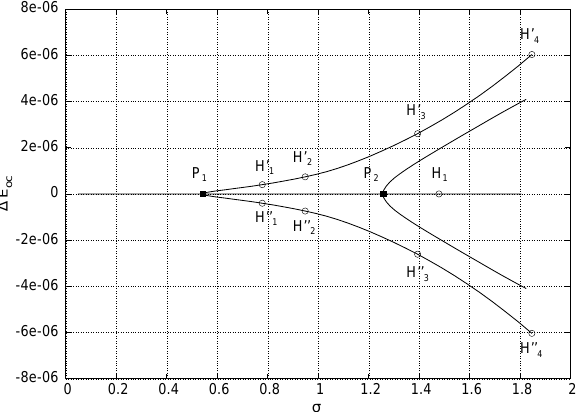
Fig. 2: Bifurcation diagram of the oceanic circulation. The energy difference ∆ E oc between the Fig. 2. Bifurcation diagram of the oceanic circulation. The en- subpolar and the subtropical gyre is plotted as a function of the wind intensity σ in nondimensional ergy difference 1E oc between the subpolar and the subtropical units; all other model parameters equal their values in Table 1. The square P 1 marks a supercritical gyre is plotted as a function of the wind intensity σ in non- pitchfork bifurcation and the square P 2 a subcritical pitchfork bifurcation, the equilibrium branch dimensional units; all other model parameters equal their values in between the two being unstable. Given the large number of unstable branches in the atmospheric Table 1. The square P 1 marks a supercritical pitchfork bifurcation model (see Fig. 5 in section 4 below), we prefer for clarity’s sake not to use the customary dashes and the square P 2 a subcritical pitchfork bifurcation, the equilib- for the unstable branches. The open circles H ′ 1 ,H ′ 2 ,H ′ 3 ,H ′ 4 and H ′′ 1 ,H ′′ 2 ,H ′′ 3 ,H ′′ 4 mark the rium branch between the two being unstable. Given the large num- positionofsuccessivesupercriticalHopfbifurcationpoints,atwhicheitherequilibriumbranchloses ber of unstable branches in the atmospheric model (see Fig. 5 in the stability of yet another complex conjugate eigenvalue; see text for details. Sect. 4 below), we prefer for clarity’s sake not to use the customary respecttotheEast-Westaxisofthebasinisbrokenandthepitchforkbifurcationtakestheperturbed dashes for the unstable branches. The circles H 0 1 ,H 0 2 ,H 0 3 ,H 0 4 form shown by Jiang et al. (1995). Still, for a wide range of σ -values, one finds a nearly antisym- 185 and H 00 1 ,H 00 2 ,H 00 3 ,H 00 4 mark the position of successive super- metric flow pattern. critical Hopf bifurcation points, at which either equilibrium branch For the value of the oceanic Reynolds number R oc =5 × 10 3 in Table 1, there are two successive loses the stability of yet another complex conjugate eigenvalue (see pitchfork bifurcations, which give respectively two branches of asymmetric equilibria, symmetric text for with respect to each other. The bifurcation at P 1 is supercritical, as the antisymmetric branch loses its stability to the two asymmetric ones, while the one at P 2 is subcritical, as the antisymmetric 190 branch regains its stability, while the two asymmetric ones that grow out of it are unstable. InFig.3,weplotanasymmetricsolutionforavalueof σ justbelowthefirstHopfbifurcation, H ′ 1 ( ∆ E oc > 0 ). Theasymmetryofthesolutioninpanel(a)isapparentfromthefactthatthesubtropical